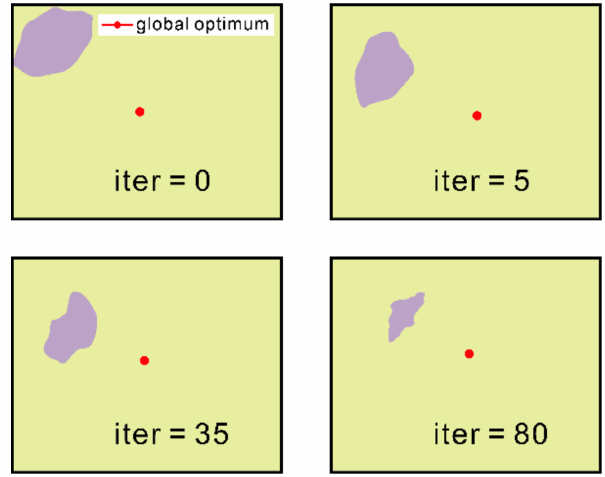
Figure 5. Schematic domain with iterations.